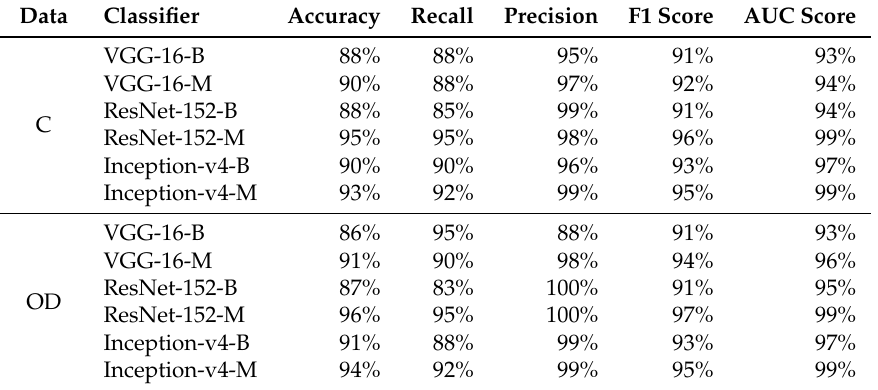
Table 5. Evaluation of model performance for glaucoma diagnosis over the testing dataset.